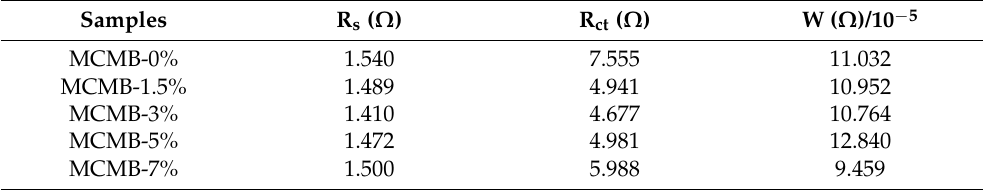
Table 5. Resistance of MCMBs calculated from an alternating current impedance spectrum.